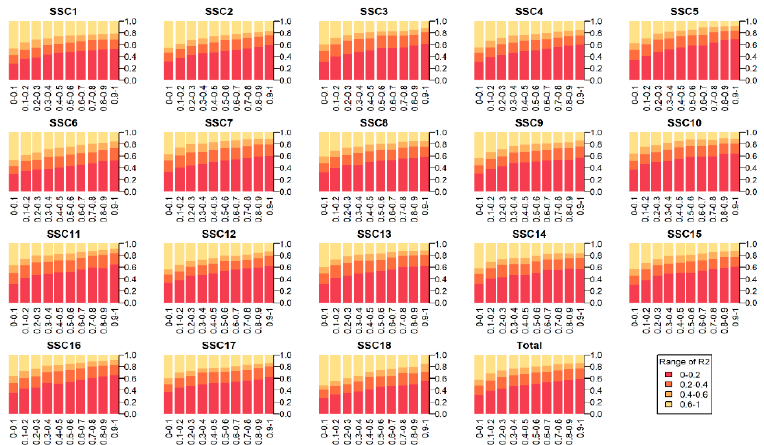
Figure 1. The tendencies of linkage disequilibrium decay across autosomes. The x-axis indicates the diverse classes of distance between SNPs pairs up to 1.0 Mb in each chromosome and the total autosomes, the y-axis indicates the proportion of varied r 2 classes.